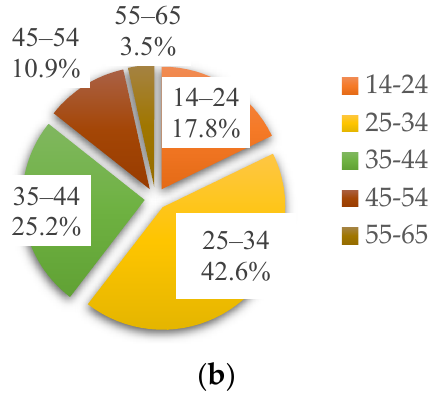
Figure 1. The tall buildings examined in Turkey: ( a ) Distribution by provinces; ( b ) Number of sto- ries.